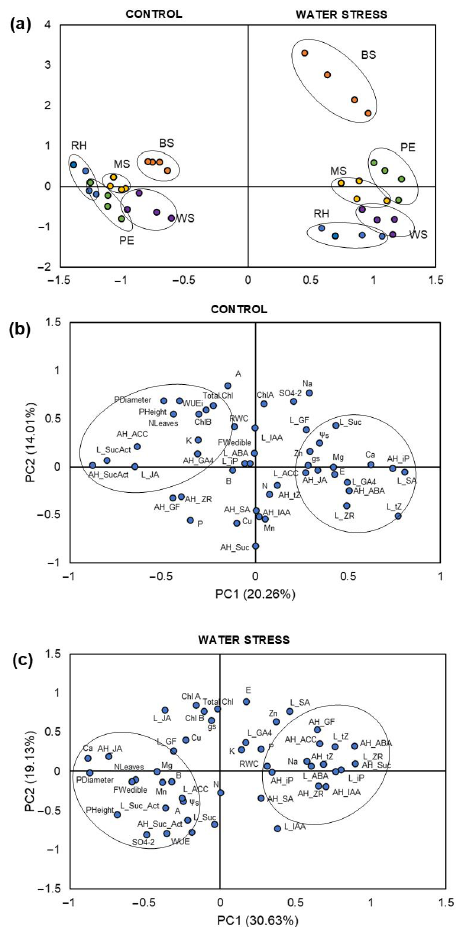
Figure 6. ( a ) Bi-plot representing the score values and ( b , c ) two axes of a principal component (PC1, PC2) analysis showing the loadings of various growth-related, ionic, sucrose metabolism, and hormonal variables (denoted by abbreviations) of artichoke plants of the commercial Symphony variety non-mulched or subjected to different mulching treatments and cultivated under control (well-watered) and water-stress (70% ETc) conditions. Circles enclose those variables/scores which cluster together in score-PCA and loading-PCA. Abbreviations used: boron (B), calcium (Ca), copper (Cu), iron (Fe), potassium (K), magnesium (Mg), manganese (Mn), sodium (Na), phosphorus (P), chloride (Cl − ), sulfate (SO4 2 − ), plant height (PHeight), plant diameter (PDiameter), number of leaves (NLeaves), edible part fresh weight (FWedible), chlorophyll a (Chl a), chlorophyll b (Chl b), total chlorophylls (Total Clh), net CO 2 fixation rate (A), stomatal conductance (gs), transpiration rate (E), intrinsic water-use efficiency (WUEi), osmotic potential ( Ψ s), relative water content (RWC),